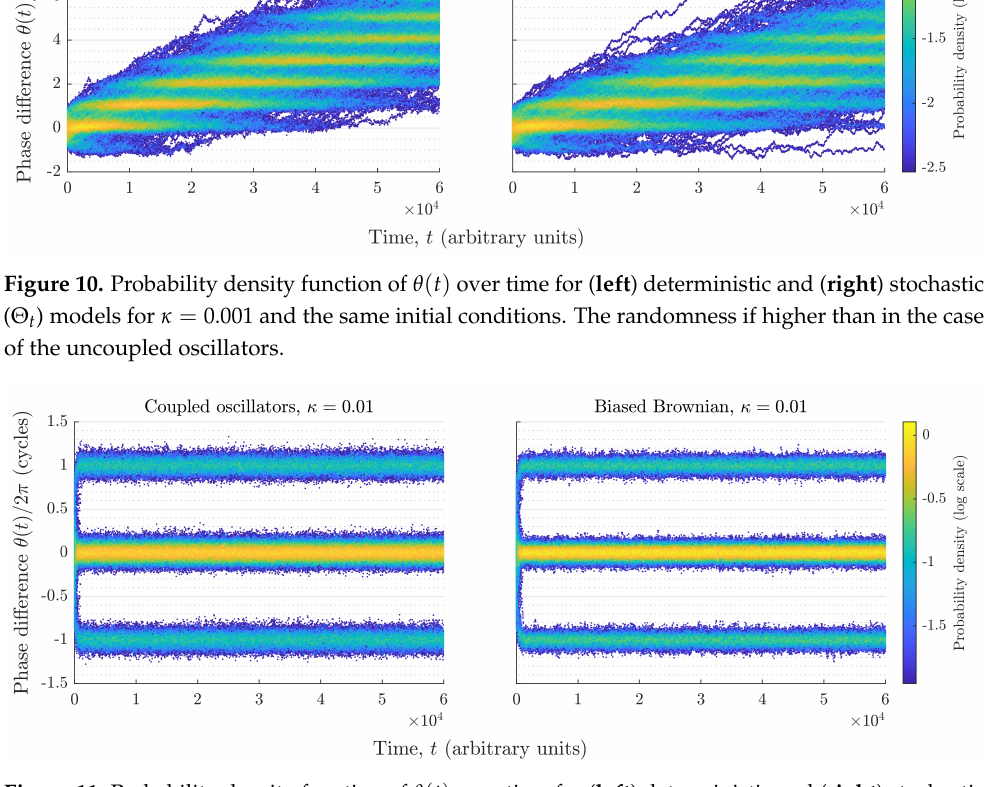
Figure 11. Probability density function of θ ( t ) over time for ( left ) deterministic and ( right ) stochastic ( Θ t ) models for κ = 0.01 and the same initial conditions. In the phase synchronization regime, both models exhibit confined Brownian-like motion. The three coexisting branches indicate underlying phase